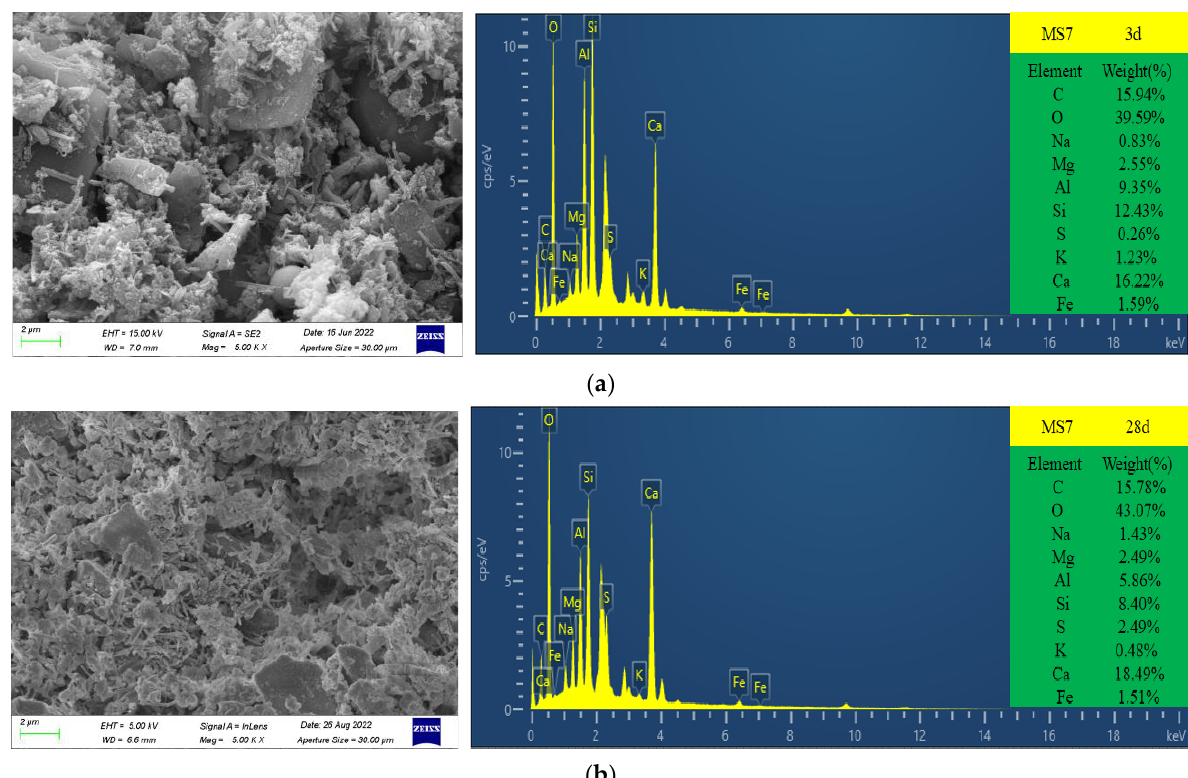
Figure 6. SEM and EDS images of MS7 sample. ( a ) T = 3d. ( b ) T = 28d.